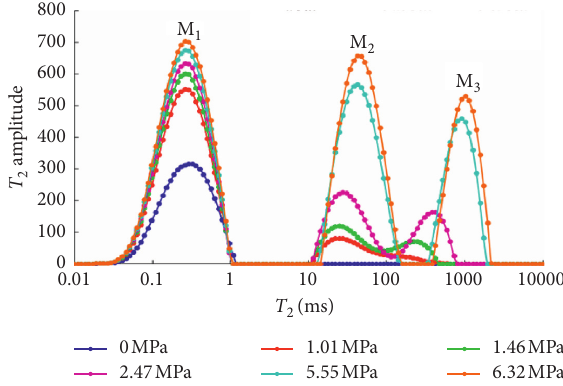
Figure 10: T 2 spectra of polymorphic methane in crushed coal under different pressures.